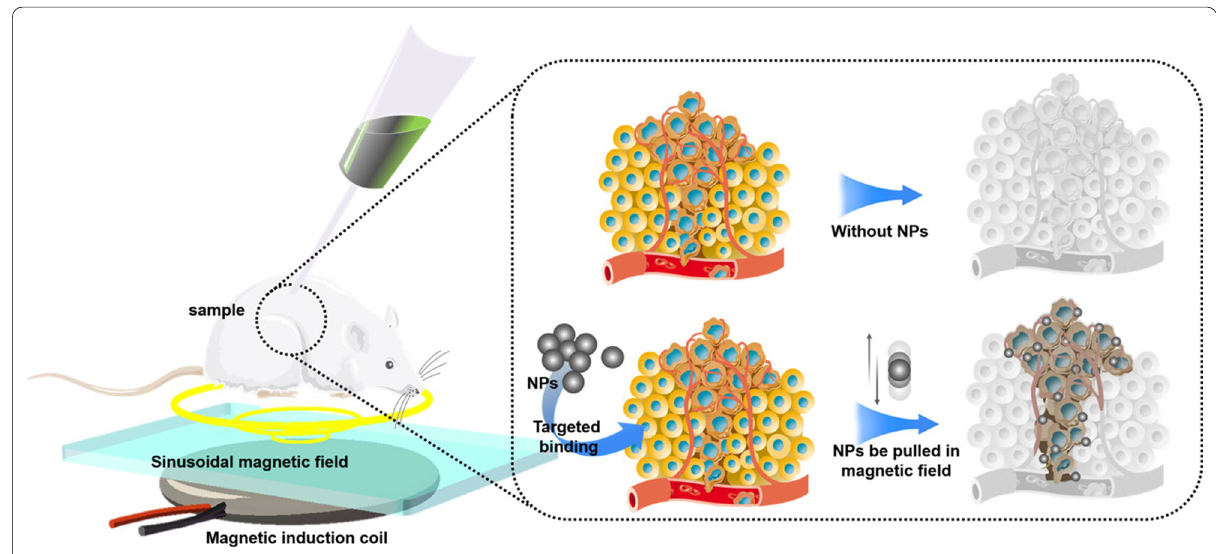
Fig. 2 Diagrammatic illustration of imaging improved of NPs